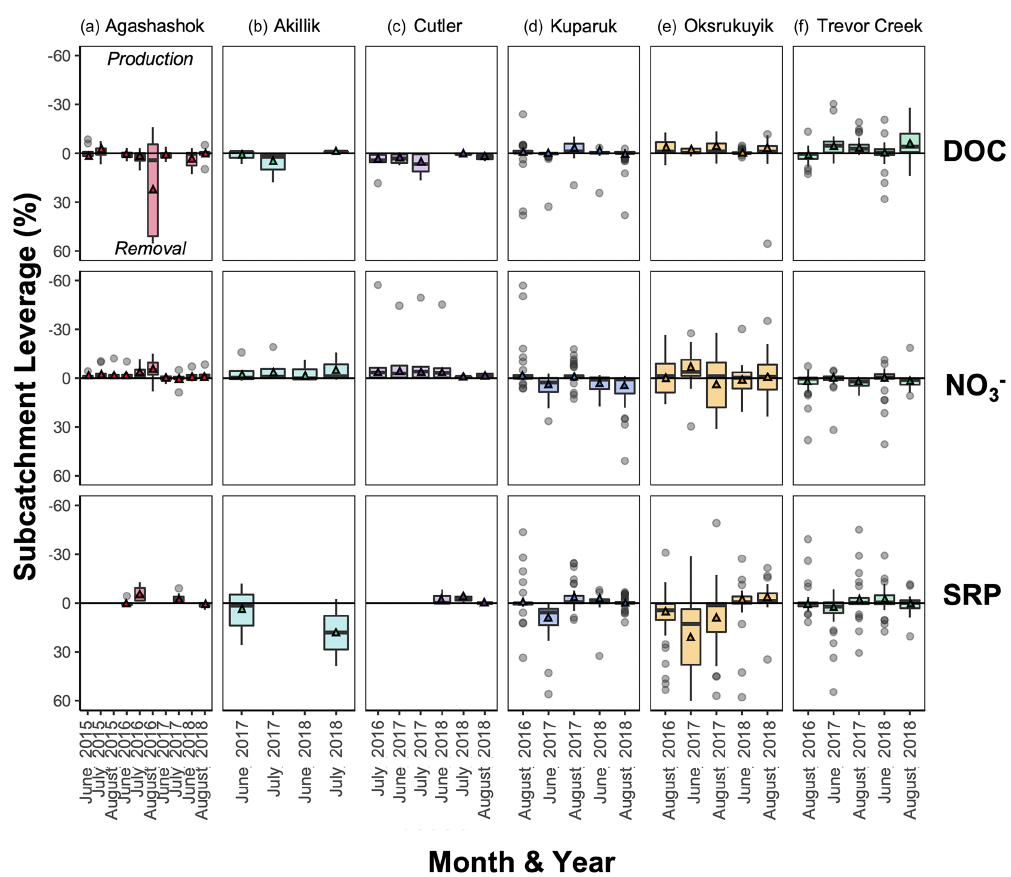
Figure 6. Boxplot of subcatchment leverage for select reactive solutes (DOC, NO 3 − , and SRP) in the (a) Agashashok River, (b) Akillik River, (c) Cutler River, (d) Kuparuk River, (e) Oksrukuyik Creek, and (f) Trevor Creek watersheds across all years and seasons sampled. Note reversed axes for ease of interpretation: negative values above the 0 line indicate production; positive values below the 0 line indicate removal. Each box encapsulates values within the lower 25th and upper 75th quartiles respectively, while the whiskers represent the minimum and maximum quartiles. Within each box, the horizontal line represents the median leverage value and the colored triangle lies at the mean. Data points outside the whiskers represent values above and below 1 . 5 × the IQR